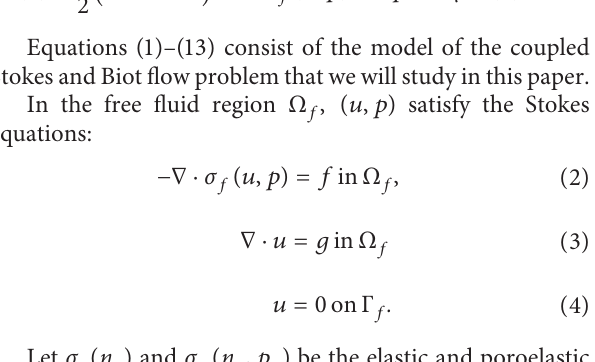
Figure 1: Global domain Ω consisting of the fluid region Ω the poroelastic media region Ω p separated by the interface Γ fp